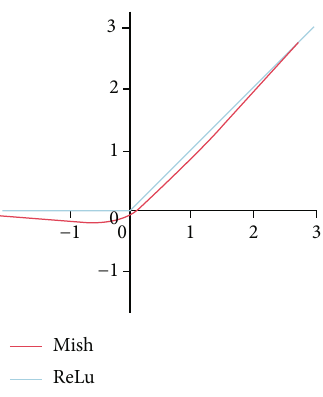
Figure 6: Mish function and ReLu function